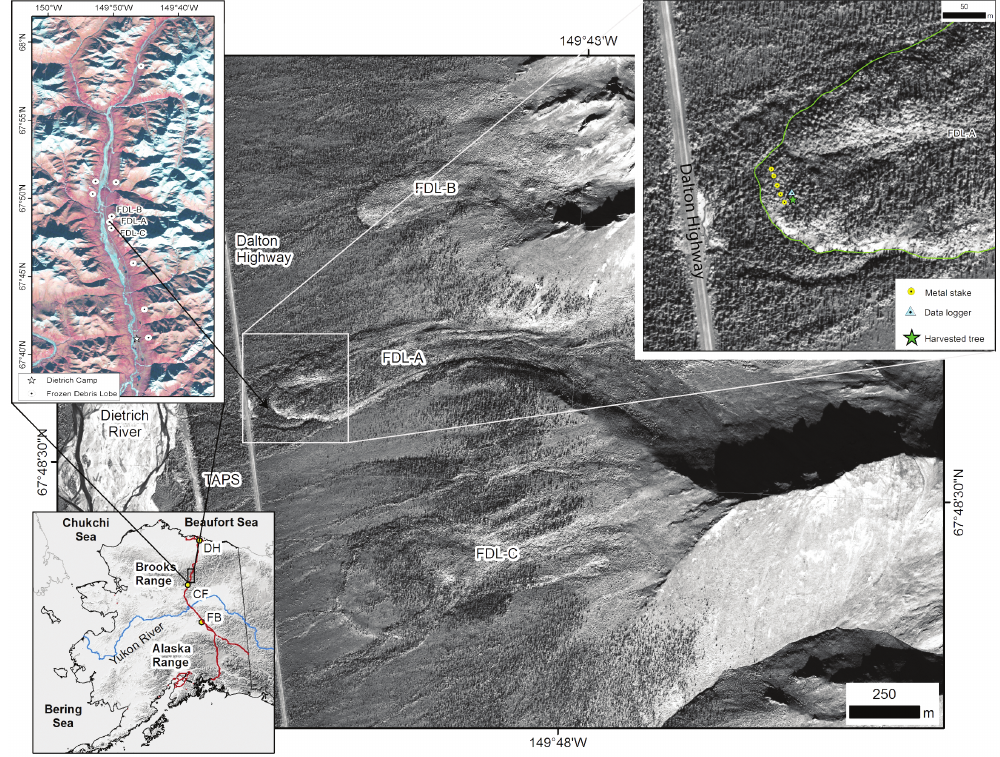
Fig. 1. Location of the study area and frozen debris-lobes (FDL) A, B and C (Image from 2008 WorldView-1, © Digital Globe). The Dietrich River, the TransAlaska Pipeline System (TAPS) and the Dalton Highway are shown to the west of the studied FDLs. Lower left inset indicates the study area (black rectangle) within the Brooks Range; FB is Fairbanks, CF is Coldfoot and DH is Deadhorse at the northern end of the Alaska Highway system (maroon line). Upper left inset shows the distribution of frozen debris-lobes along the Dalton Highway and this map is based on a Landsat-5 TM image (bands 4-3-2) from 19 September 2010 (USGS/NASA). Upper right inset shows the terminus of FDL-A with measurement